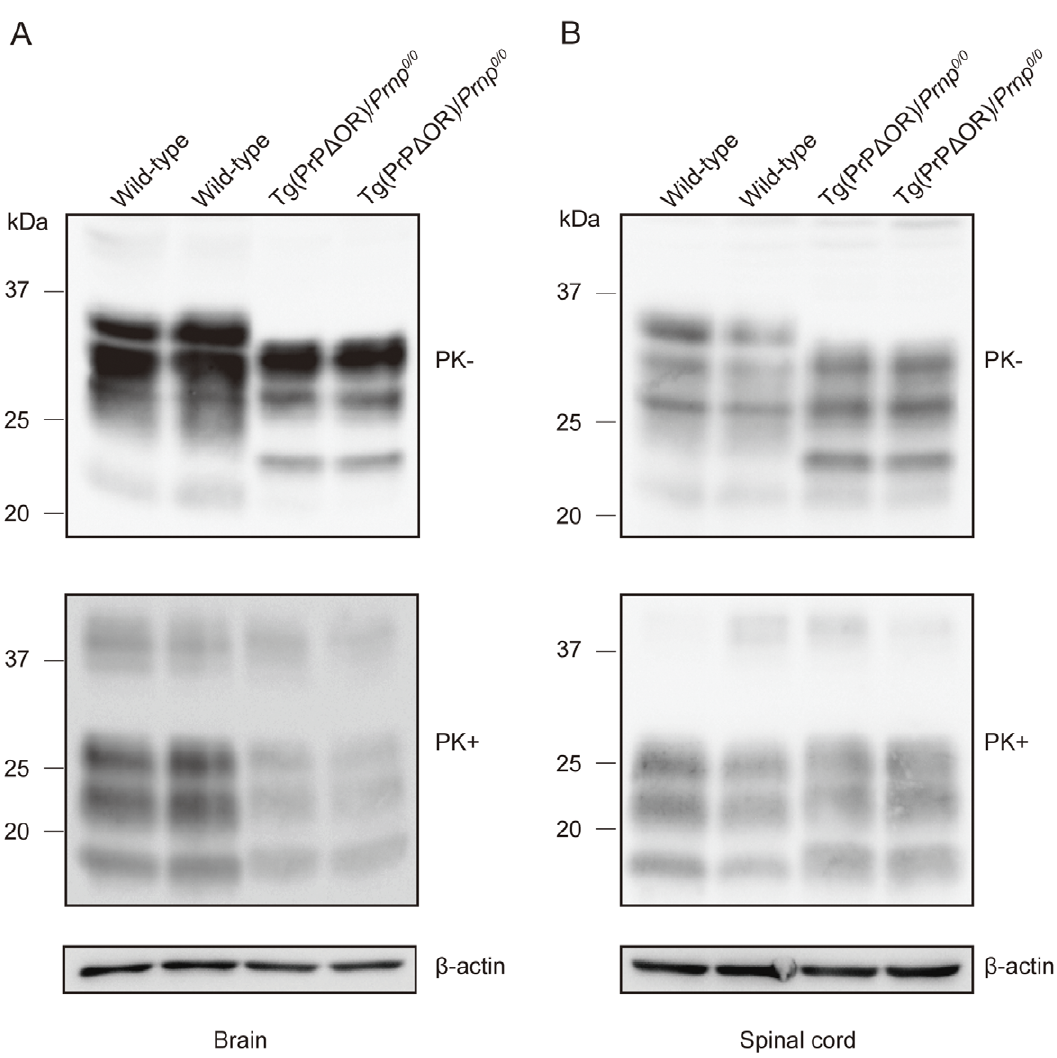
Figure 3. PK-resistant PrP accumulated in the brains and spinal cords of terminally ill tg(PrP D OR)/ Prnp 0/0 mice. Immunoblots of the two PK-treated individual brains (A) and spinal cords (B) from terminally ill wild-type and tg(PrP D OR)/ Prnp 0/0 mice using SAF61 anti-PrP antibodies.